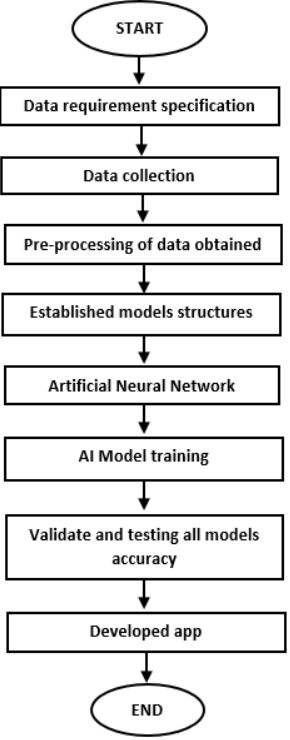
Figure 2. The flowchart based on the research.